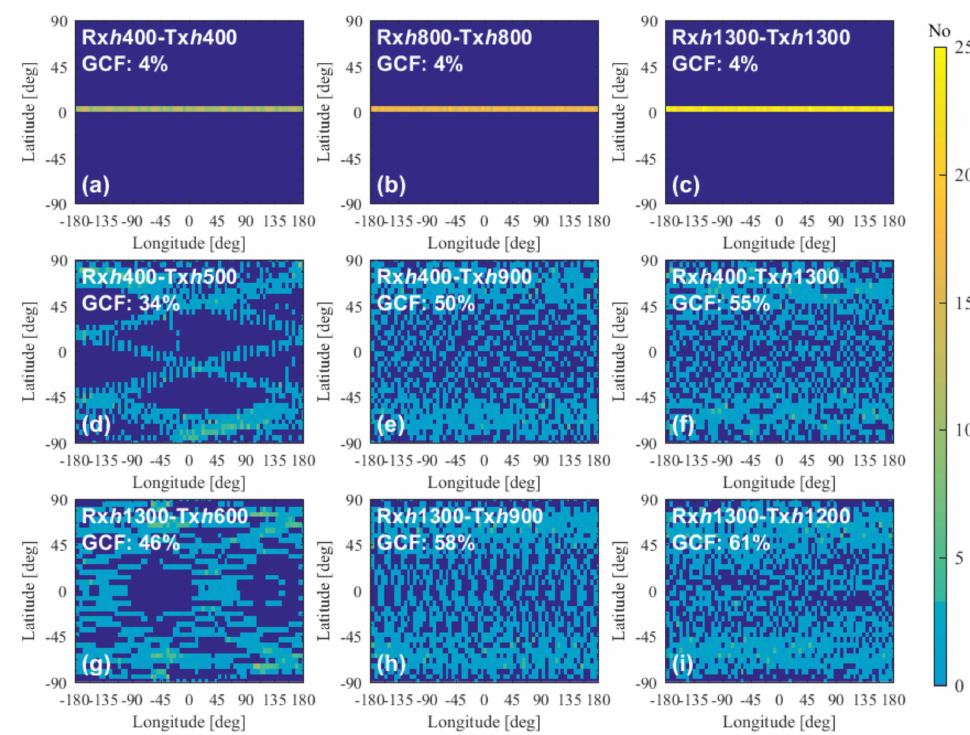
Figure 9. The global coverage of LEO-LEO occultation events for representative Rxi98-Txi82 constel- lations composed of a Rx satellite and a Tx satellite with particular orbital heights, illustrating the occultation numbers per 5 ◦ × 5 ◦ latitude and longitude grid cell. The GCFs were calculated using grid cell areas according to Equation (12).